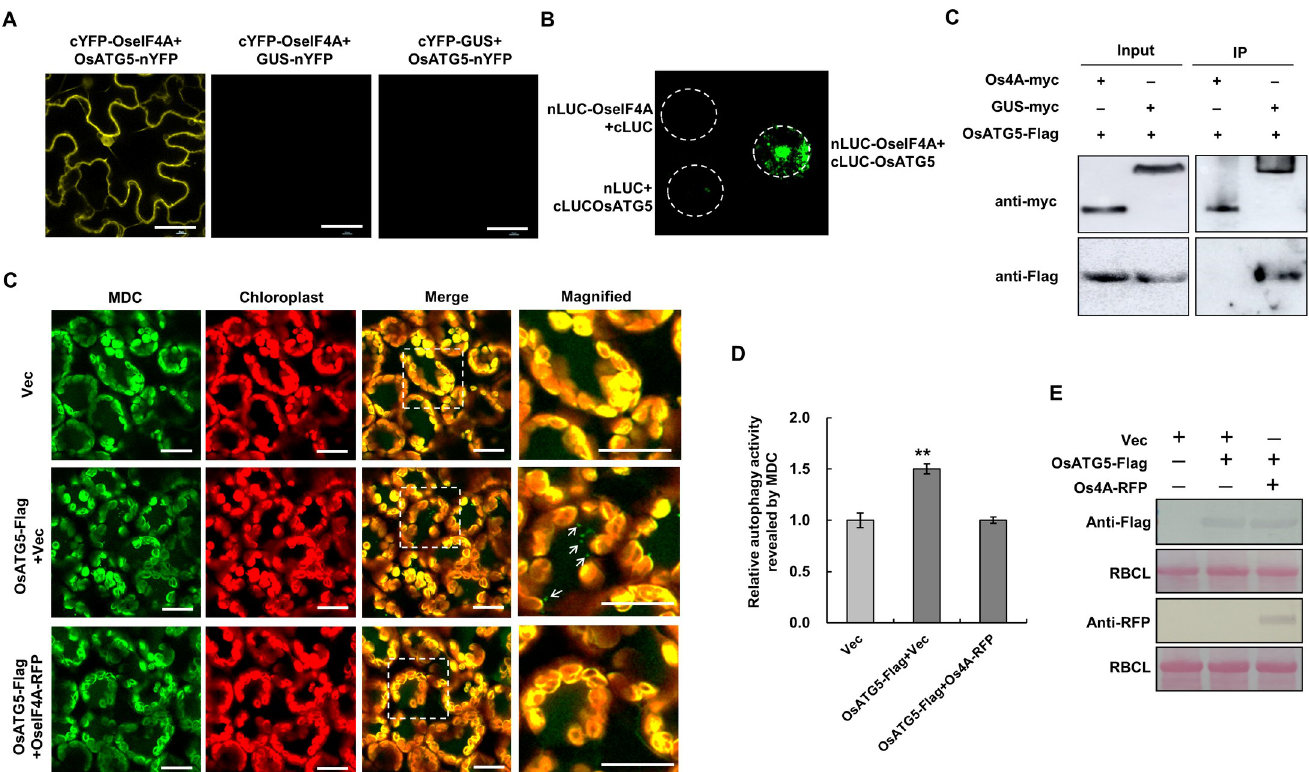
Fig 7. Rice eIF4A (OseIF4A) Interacts with Os ATG5 and Suppresses Os ATG5-Activated Autophagy. (A–C) Interaction of Os eIF4A with Os ATG5, as assessed by BiFC (A) , LIC (B) , and Co-IP (C) assays. (D, E) Representative confocal images of autophagic activity in N . benthamiana cells expressing Os ATG5 and co-expressing Os ATG5 and Os eIF4A revealed by MDC staining (D) , and relative normalized autophagic activity (E) . Green: MDC-stained structures; red: chlorophyll autofluorescence. Relative autophagic activity was normalized to that of cells expressing empty vector. Quantification of MDC-stained structures (autophagic foci per cell) was performed by counting autophagic bodies to calculate autophagic activity. More than 150 cells per treatment were used for quantification. Error bars indicate standard error from three individual experiments. Asterisks indicate significant differences by Student’s t -test ( �� , p < 0.01) compared to the control. (F) Immunoblot analysis of the accumulation of proteins in Agrobacterium-infiltrated